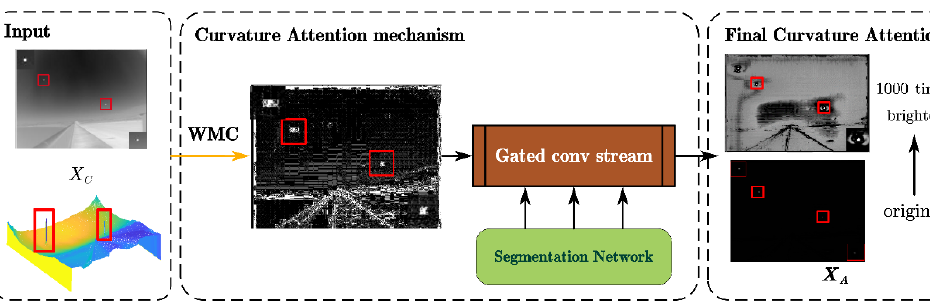
Figure 3. Structure of curvature attention